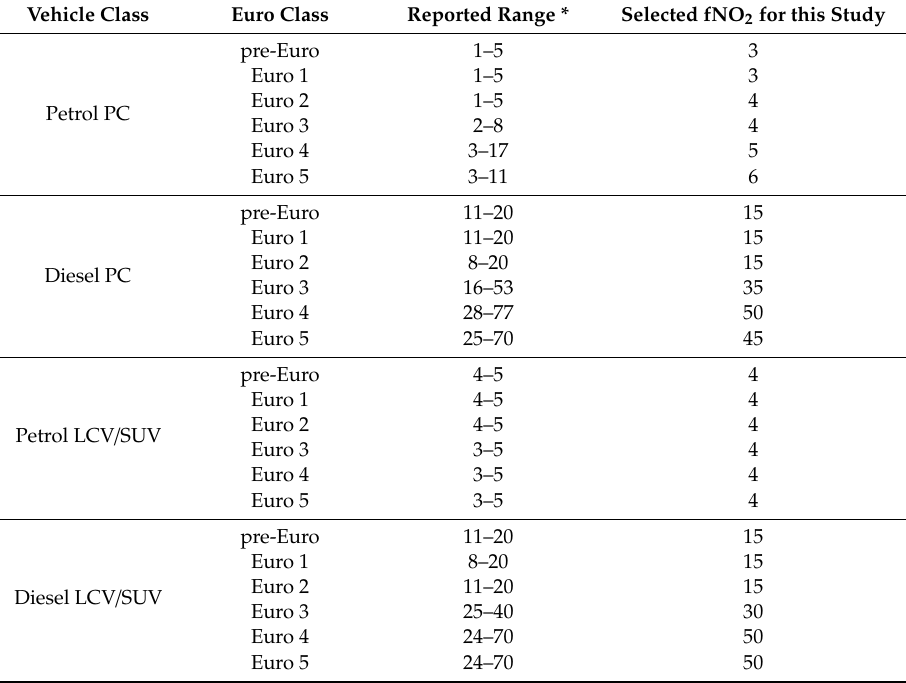
Table 2. NO 2 to NO x ratios: reported ranges * and selected values for this